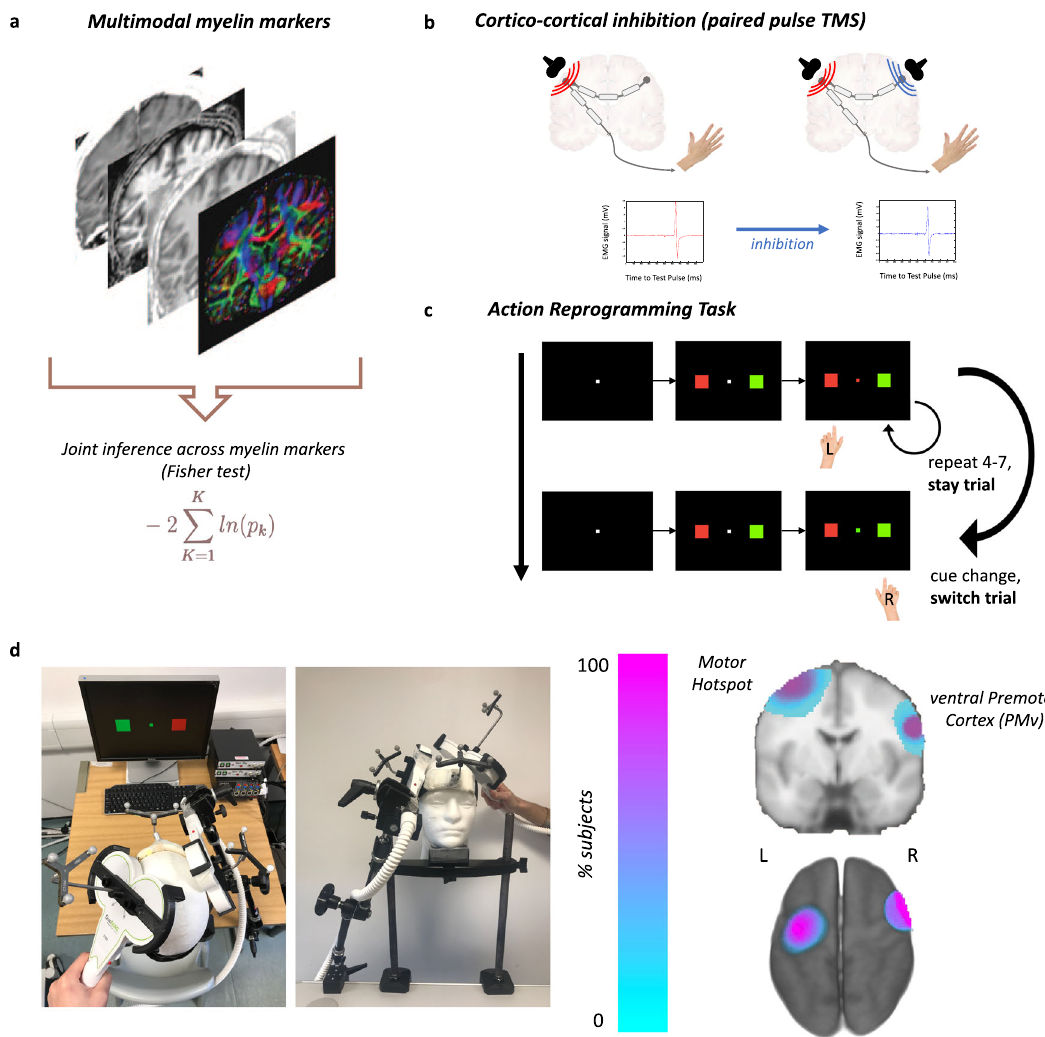
Fig. 1 Non-invasive measurement of myelination and of cortico-cortical interactions during behaviour. a Multiple myelin-sensitive MRI modalities were collected and jointly analysed through multimodal joint inference. b Motor-evoked potentials were collected from the same participants during an action reprogramming task. Stimulation of premotor cortex during the task allowed measurement of the modulatory effects of premotor cortex on motor-evoked potentials driven by M1 stimulation. More speci fi cally, in a single pulse condition (SP, left) a test pulse (red) over left motor cortex elicits a motor-evoked potential in the right hand; in a paired pulse condition (PP, right) the test pulse (red) is preceded by a conditioning pulse (blue) over right ventral premotor cortex. The ratio of hand motor-evoked potential amplitude between the single pulse and paired pulse conditions during switch trials (switch PP/SP ratio) is our measure of cortico-cortical interaction. c Schematic of the action reprogramming task. The ratio between reaction times in stay trials and switch trials (switch RT cost) is our primary behavioural measure. d Transcranial magnetic stimulation set-up used to measure cortico-cortical interactions (left). Precise neuroanatomical targeting is achieved through continuous neuronavigation during stimulation, and con fi rmed with analysis of subject-speci fi c target locations of stimulation